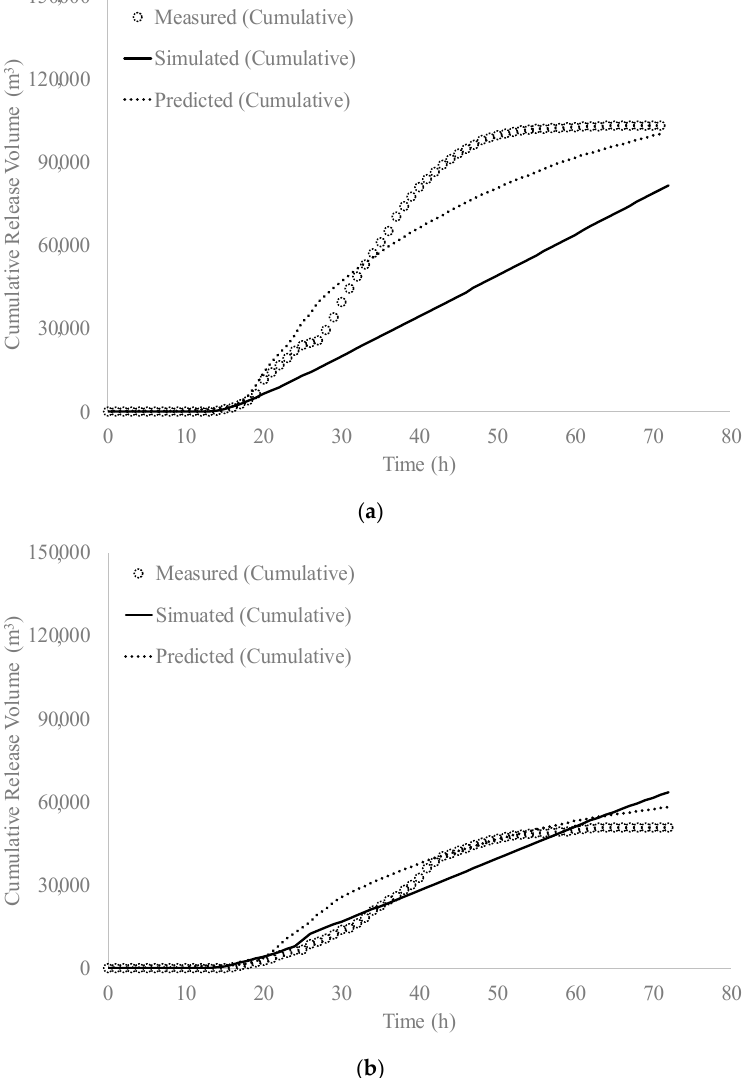
Table 2. Comparison of the measured, simulated, and predicted release amount of bottom outlets during typhoons from 2015 to 2016.